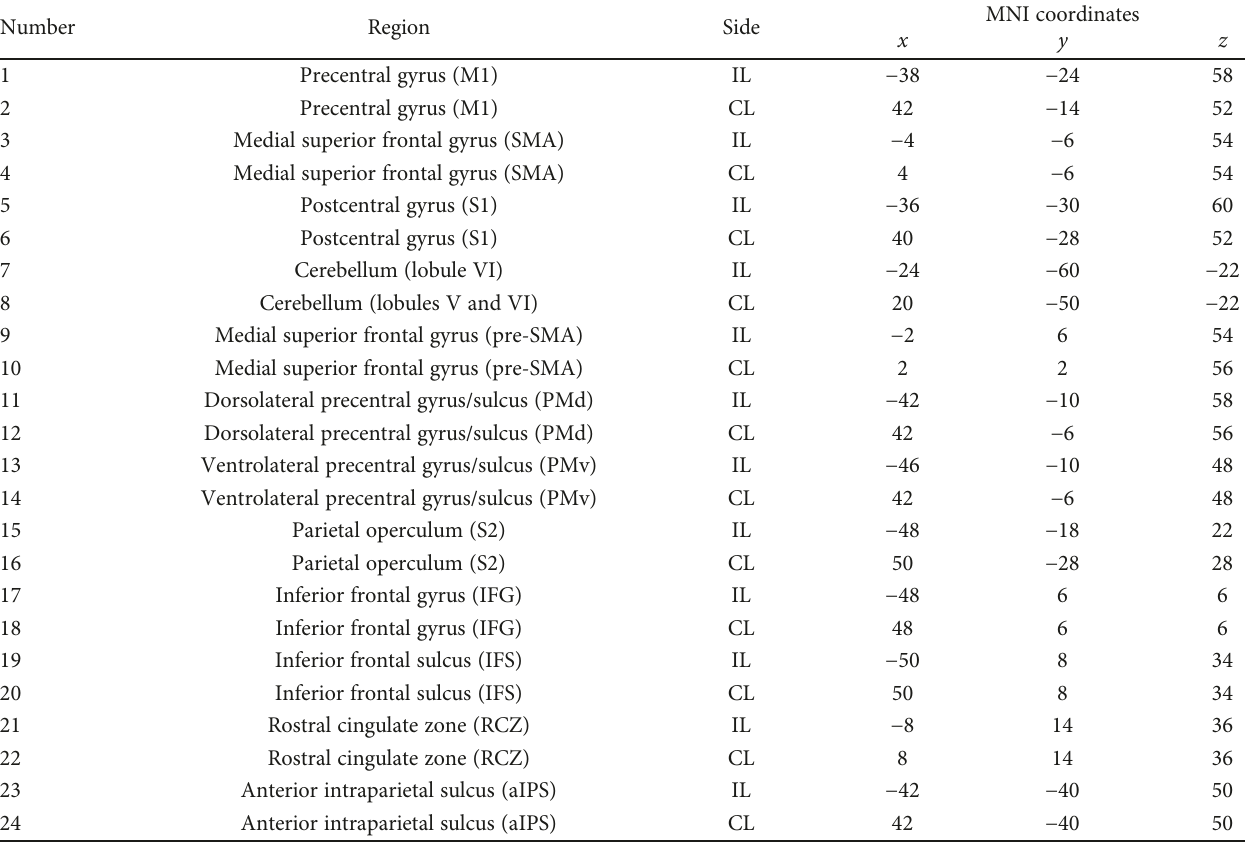
Table 2: Regions of interest in the motor networks of stroke